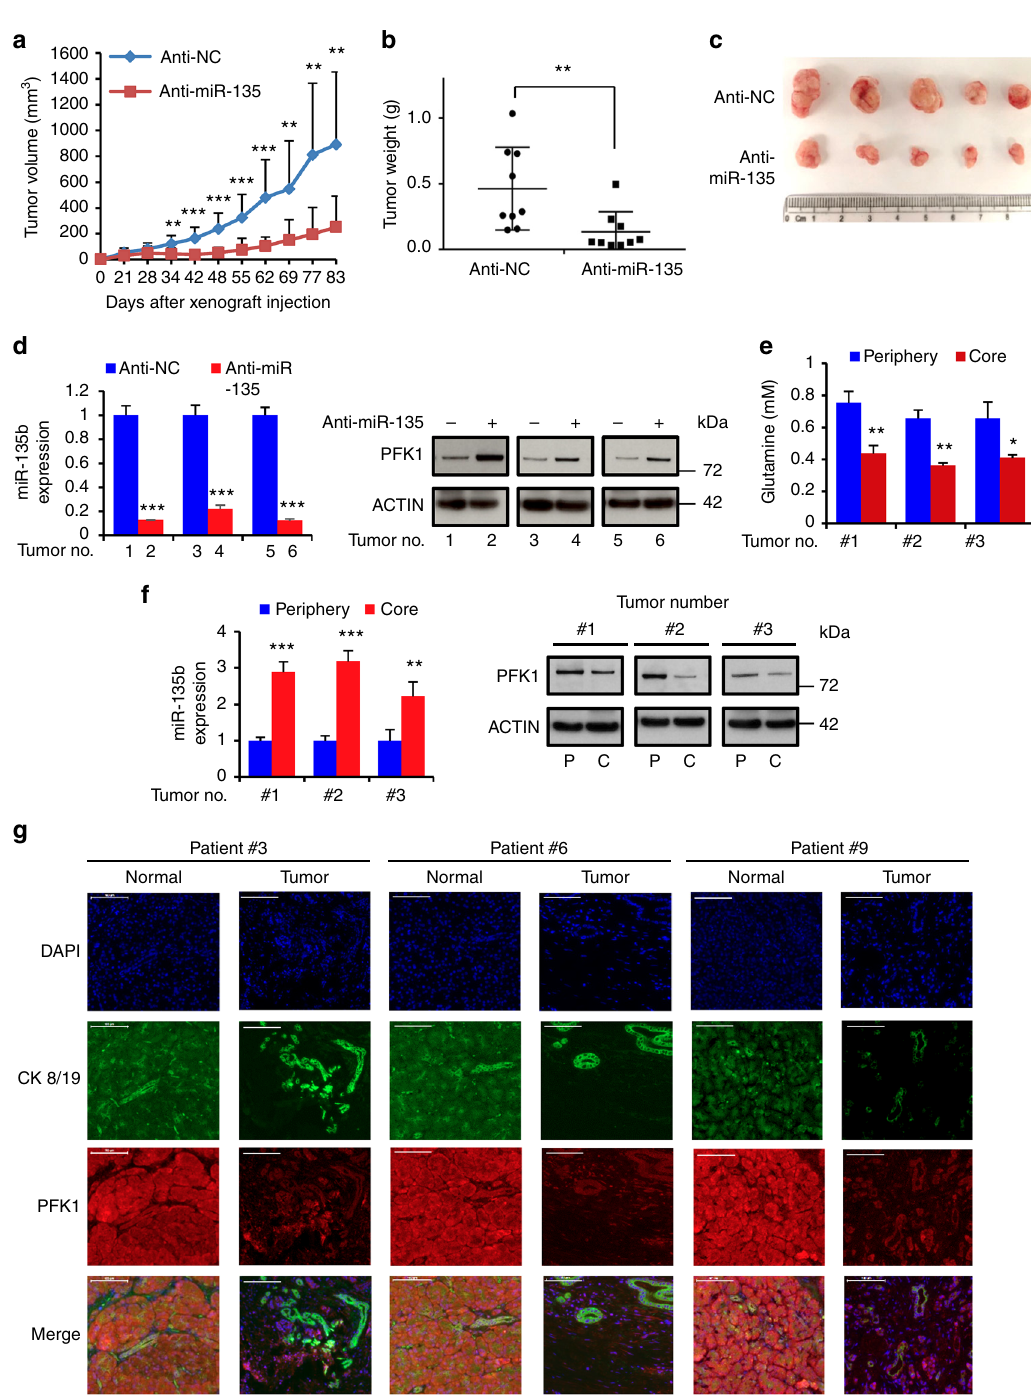
Fig. 7 Suppression of miR-135 in PDAC cells represses tumor growth. Nude mice were injected subcutaneously with Control (anti-NC) and miR-135 knockdown (anti-miR-135) MIA PaCa-2 cells. a Tumor size was measured over time ( n = 9 mice per group). b Tumor weight was measured after tumors were harvested from mice ( n = 9 mice per group). Each value represents the mean ± SD. ** p < 0.01, *** p < 0.001, Student ’ s t test. c Representative tumors from each group. d miR-135b expression was determined in xenograft tumors by qPCR and PFK1 protein was assessed by western blotting. e Glutamine concentration in samples from peripheral or core regions of control tumors. f miR-135b was determined by qPCR and PFK1 protein was measured by western blotting analysis in the core and periphery regions. (C: core; P: periphery). Each value represents mean ± SD in three independent experiments. * p < 0.05, ** p < 0.01, *** p < 0.001, Student ’ s t test. g Pancreatic patients ’ tumor and adjacent normal tissues were stained with DAPI, CK8/19 and PFK1 antibody. Scale bar = 100 µ m. PDAC: pancreatic ductal